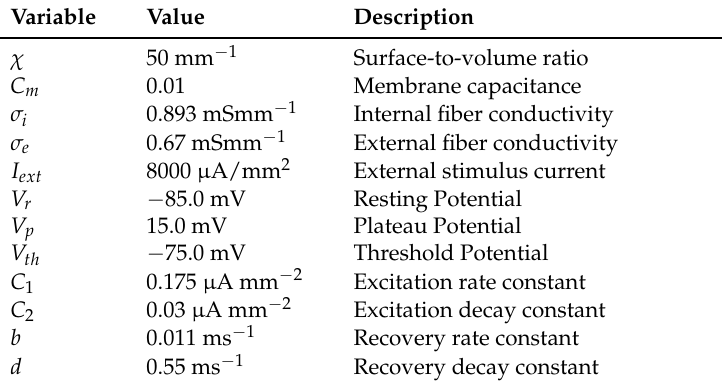
Table 1. Values for the cell model, and the monodomain